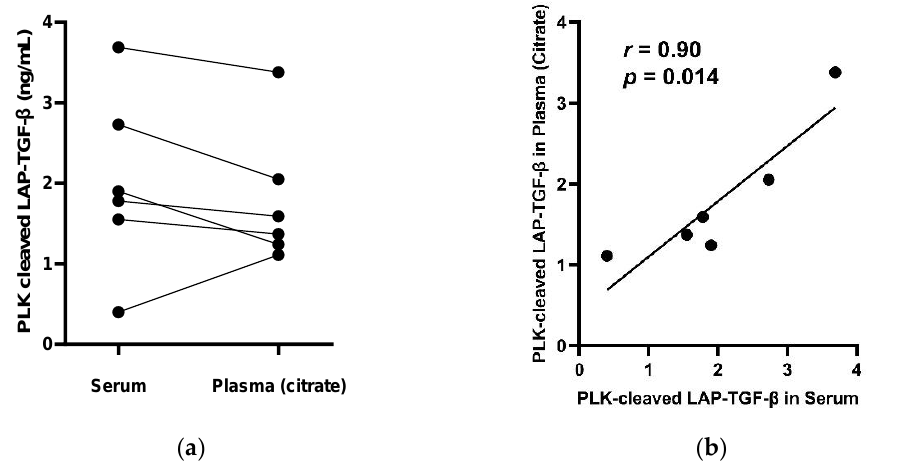
Figure 3. Biomarker levels of PLK-cleaved LAP-TGF- β in matched serum and citrate plasma samples: ( a ) Matched samples are connected by lines. ( b ) Correlation between the serum and plasma PLK-cleaved LAP-TGF- β levels shown in (a) was tested with Pearson test; Pearson’s r ( r ) and p -values are shown. The line represents simple linear regression.